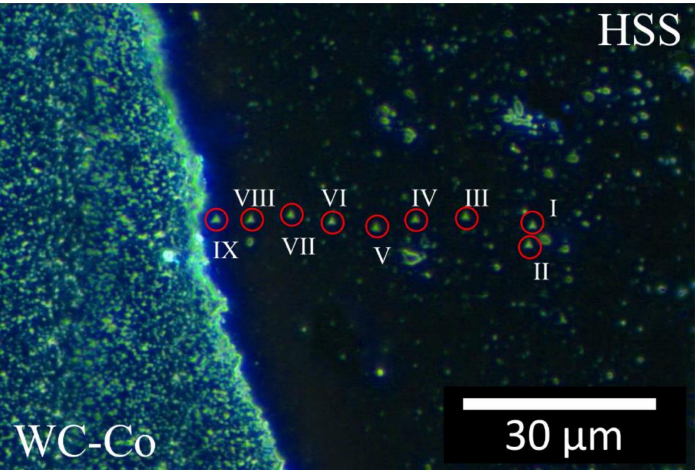
Figure 17. Dark Field Optical Microscopy image of an nIIT array across the weld-line. Here the transitional layer is very narrow, that is, less than 10 µ m, as in Figure 10. The red circles and Roman numerals indicate the nine nano-indentation imprints on the HSS side; it should be pointed out that the profile continues on the WC-Co side, but it is not possible to discern the nano-indentation imprints by means of